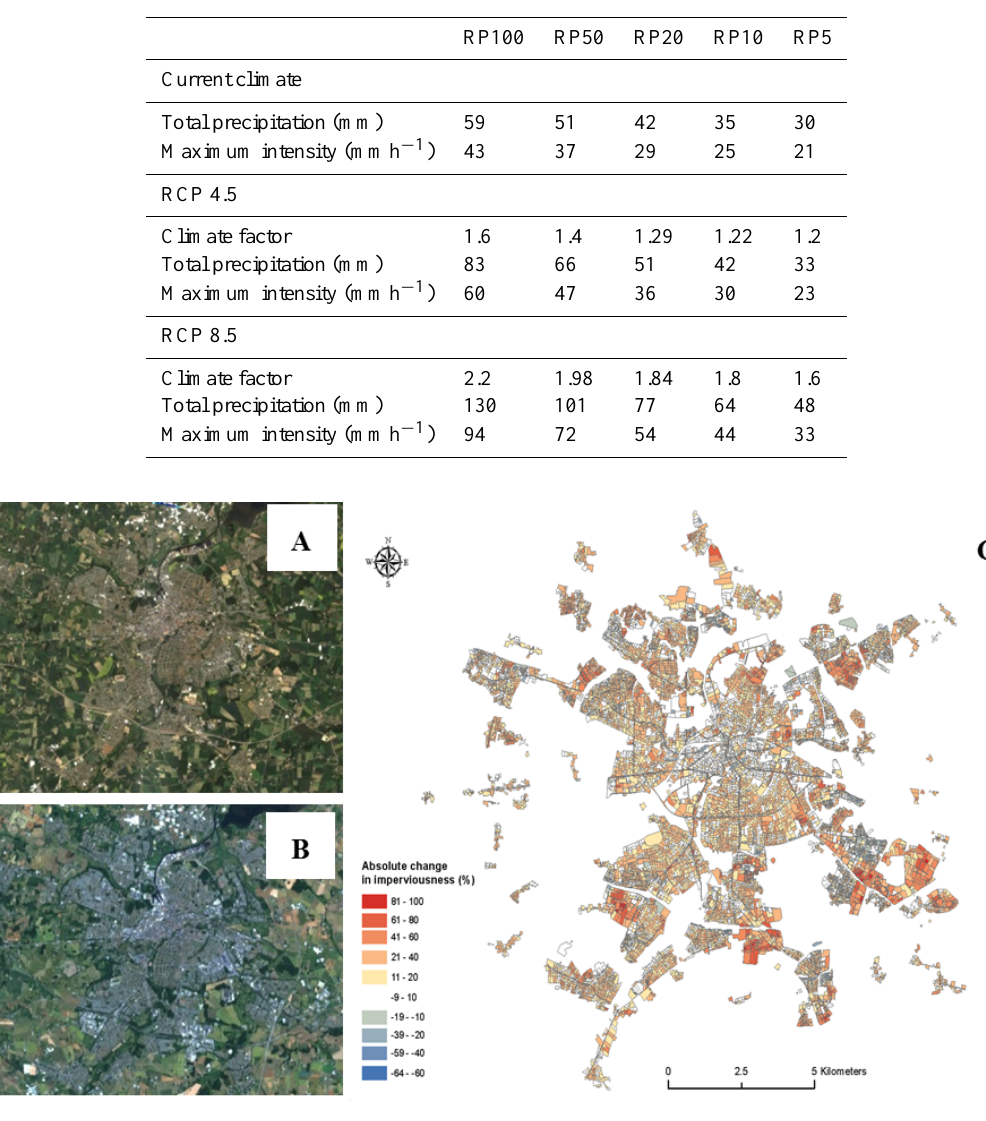
Figure 2. Landsat TM image Odense 1984 (a) , Landsat OLI image Odense 2014 (b) , Absolute change in imperviousness in Odense